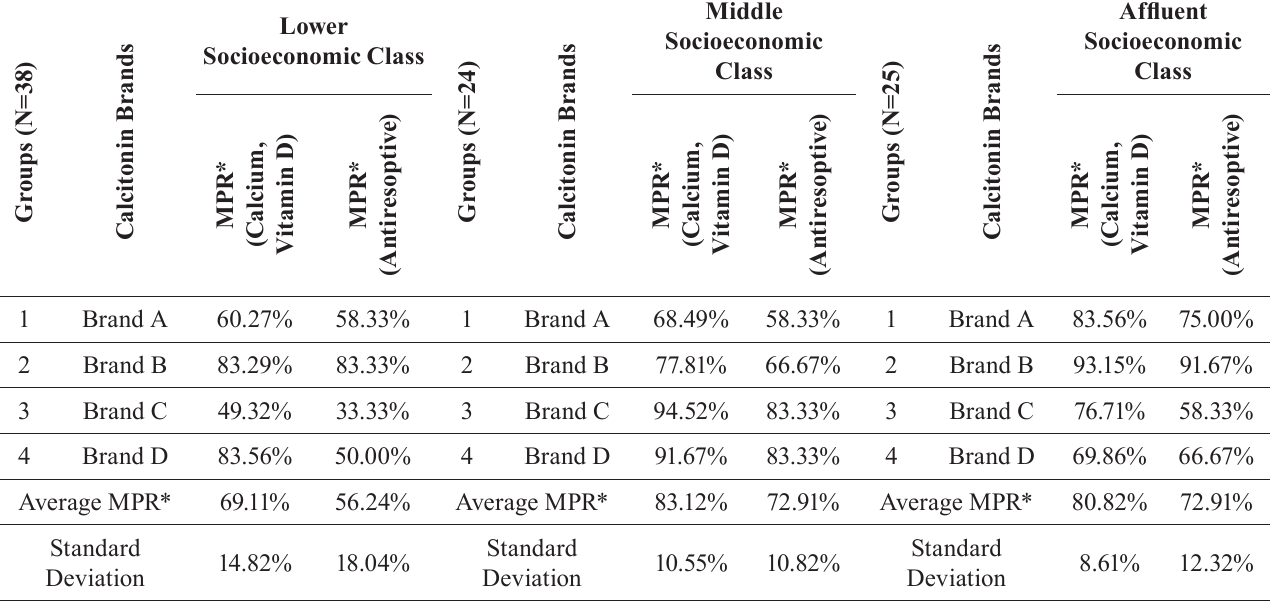
TABLE II - MPR of Calcitonin Brands, Calcium, Vitamin D in different Socioeconomic Classes